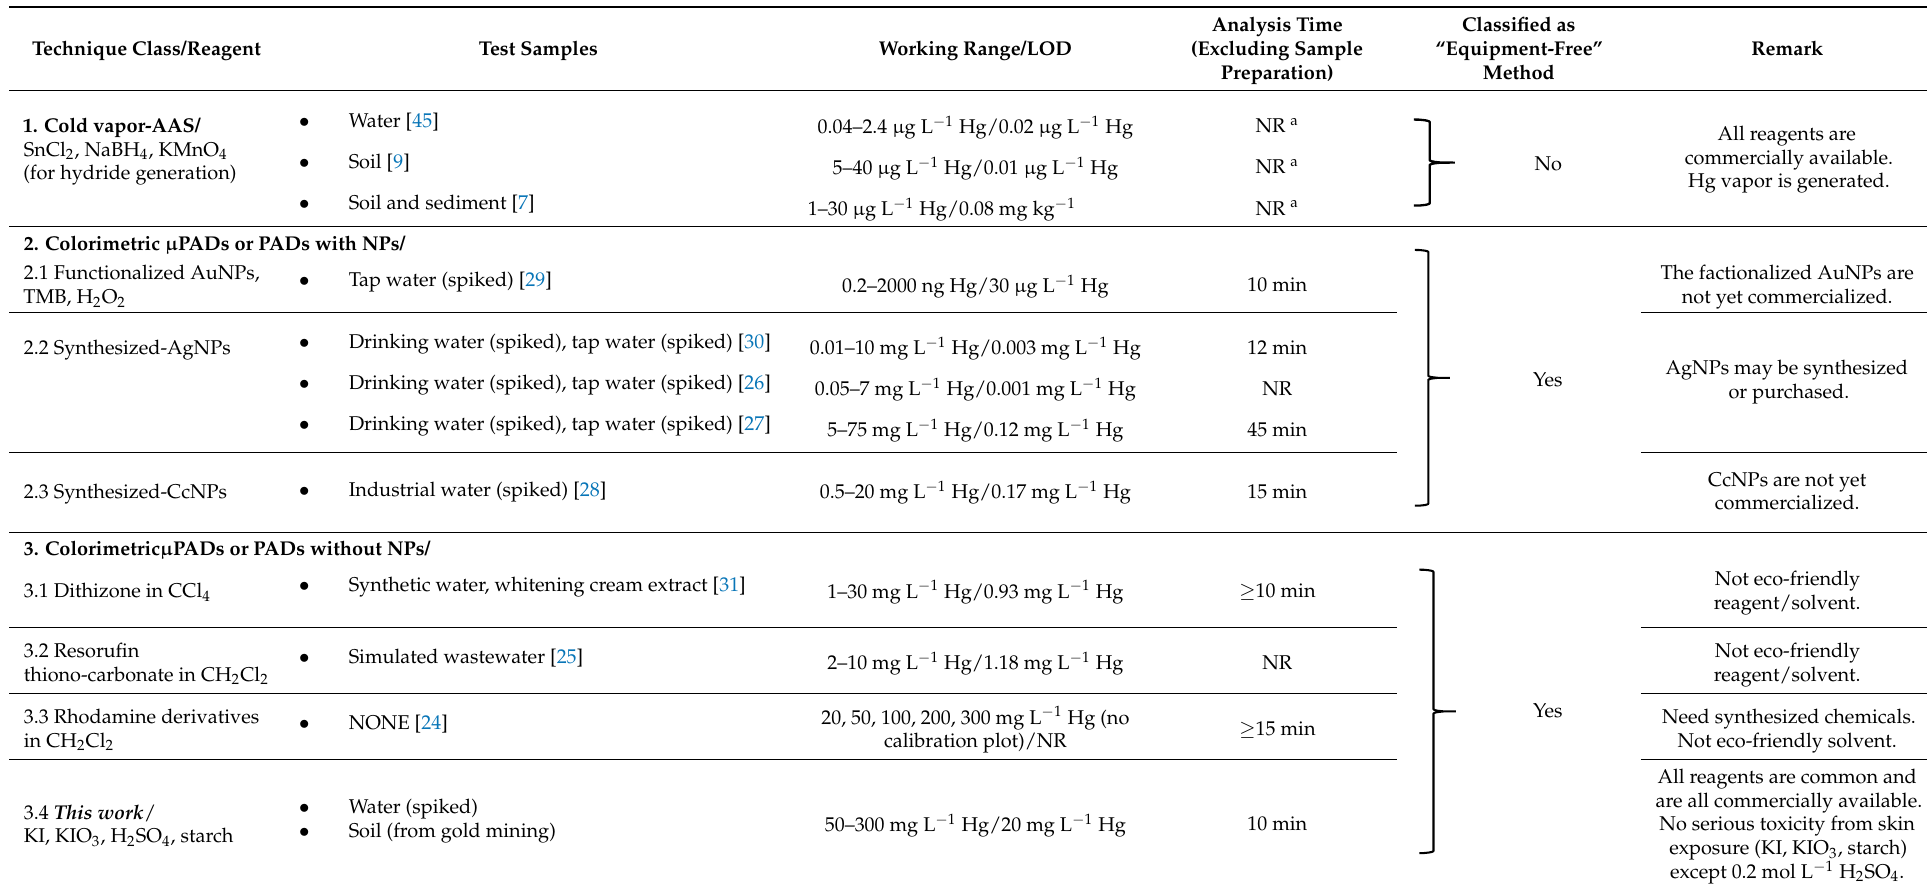
Table 4. Comparison of the analytical features of various techniques for the determination of mercury.